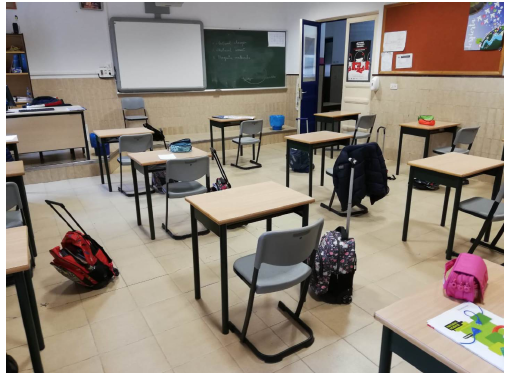
Figure 7. Implementation of the optimized distribution into the original